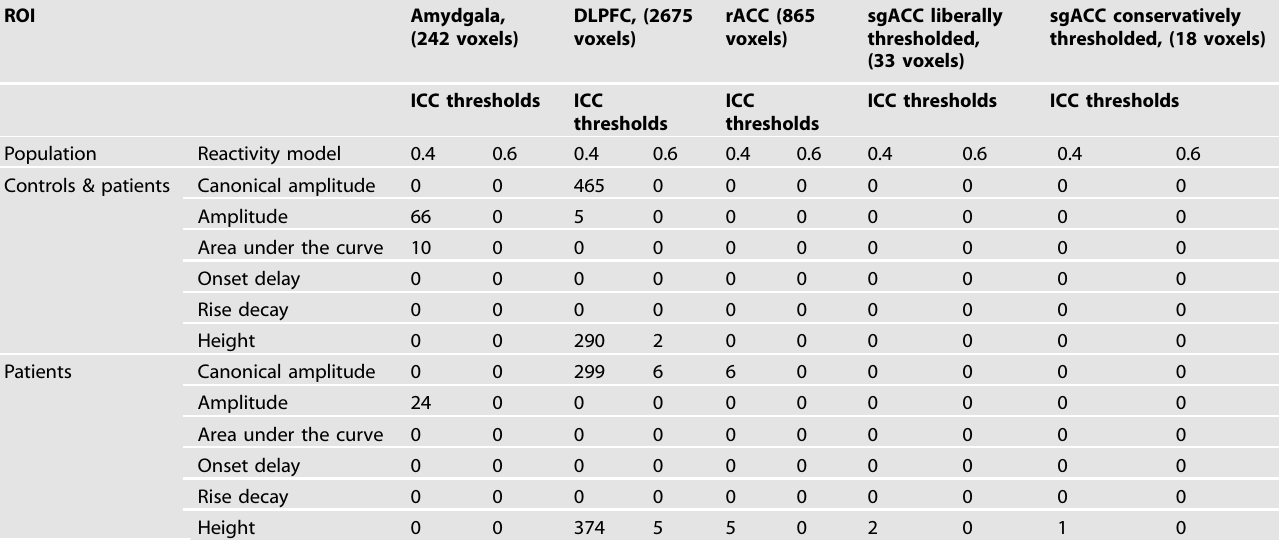
Table 2. Table of number of voxels reaching different reliability thresholds for each sample, fi rst level parameter, and ROI with cluster correction